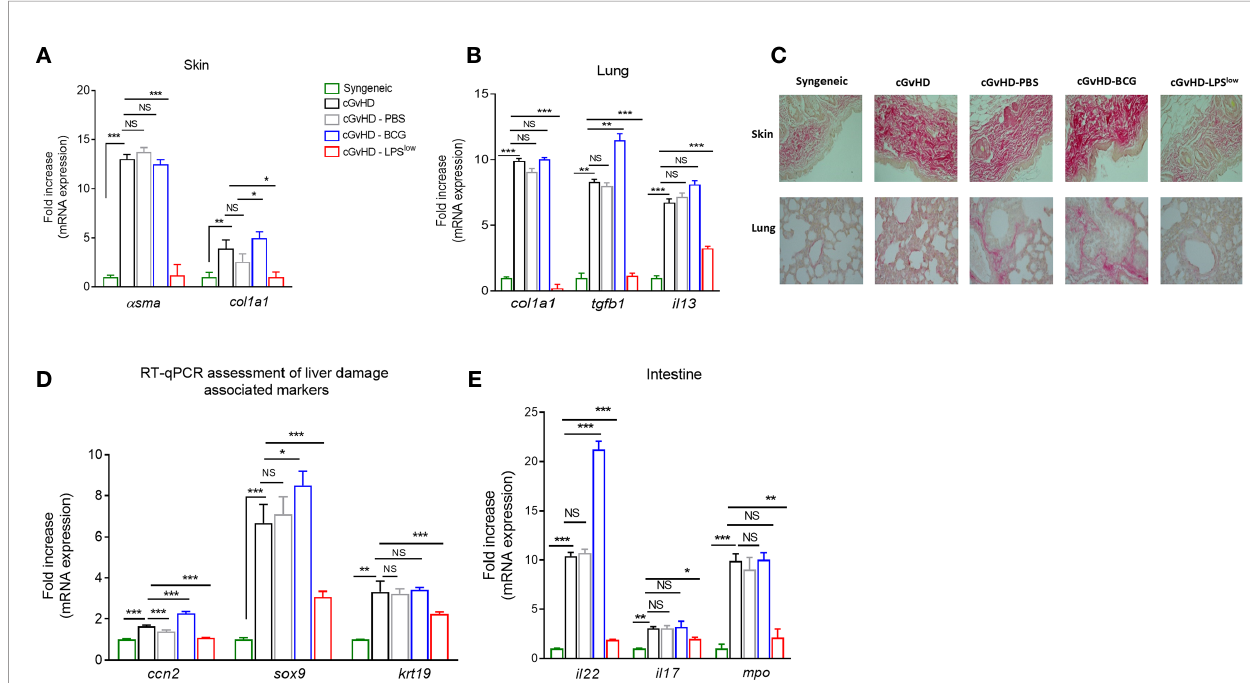
FIGURE 5 | LPS low -macrophages serve as protective barrier against cGvHD-induced tissue/organ injury. (A, B) RT-qPCR assessment of a -sma and c ol1a1 mRNA levels in the skin (A) and of c ol1a1 , tgfb1 and il13 mRNA levels in the lungs (B) of cGvHD mice at sacri fi ce. Results were expressed as fold increase versus the syngeneic group, derived from at least n = 7 biologically independent mice. (C) Representative Sirius red-dyed skin and lung sections of 5 m m, showing enhanced fi brosis with accumulation of collagen in the dermis and thickening of inter-alveolar septa re fl ecting the obliterative bronchiolitis of cGvHD mice compared to syngeneic mice. Photographs were taken with a Nikon Eclipse 80i microscope. Original magni fi cation ×40. (D, E) RT-qPCR assessment of il22 , il17 , and mpo mRNA levels in the intestines (D) and of ccn2 , sox9 , and krt19 in the liver tissue (E) of cGvHD mice at day 40 of the experiment. Results were expressed as fold increase versus the syngeneic group, derived from at least n = 7 biologically independent mice. Unpaired T-test was used to detect the signi fi cance. NS, non-signi fi cant; *p ≤ 0.05; **p ≤ 0.01; ***p ≤